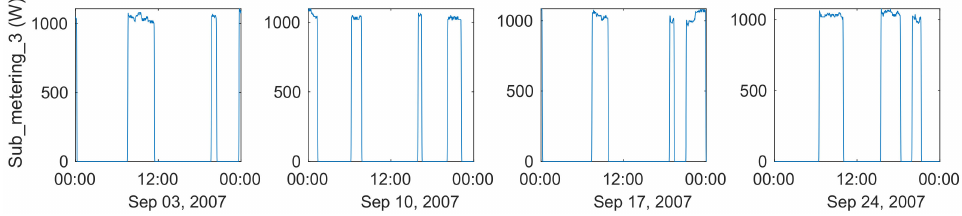
Figure 10. Sub_metering_3 power, during the four Mondays in September